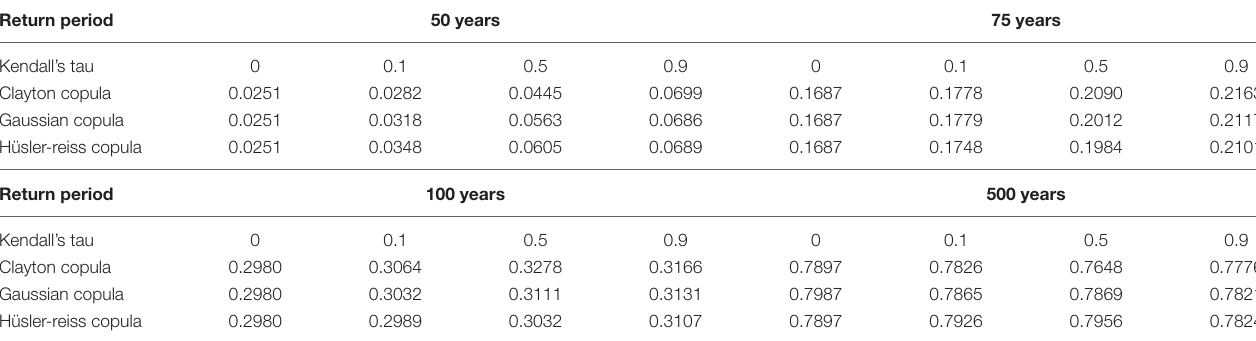
TABLE 2 | Probability of failure of the bridge associated with different copula models under 50-, 75-, 100-, and 500-year hurricane scenarios. Return